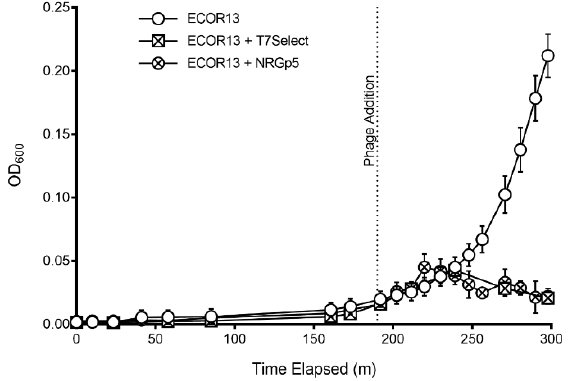
Figure 2. Phages (NRGp5 or T7 Select) were added to individual cultures of E. coli (ECOR13) after 3 h of enrichment. The E. coli in samples without phages added continued to the exponential phase, while the application of phages resulted in a decline in optical density after about two hours.